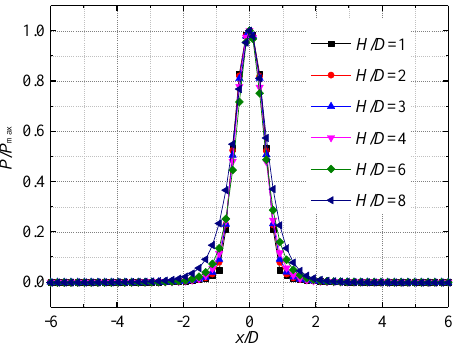
Figure 17. Variation of the pressure P/P max along the x axis in the flow direction.